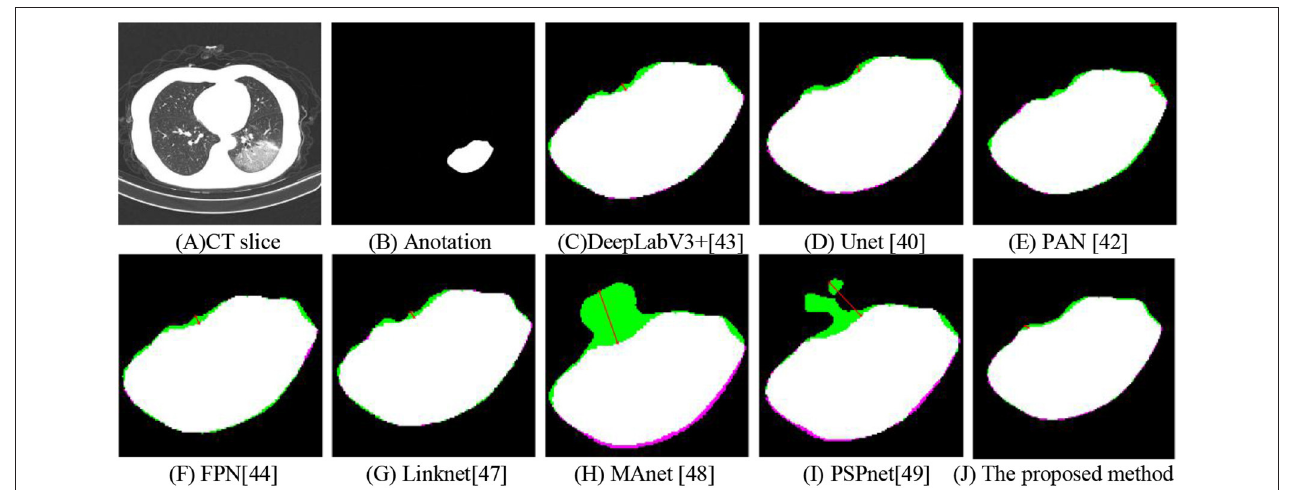
FIGURE 11 | Hausdorff distance with different methods. (A) CT slice. (B) Anotation. (C) DeepLabV3+. (D) Unet. (E) PAN. (F) FPN. (G) Linknet. (H) MAnet. (I) PSPnet. (J) The proposed method.